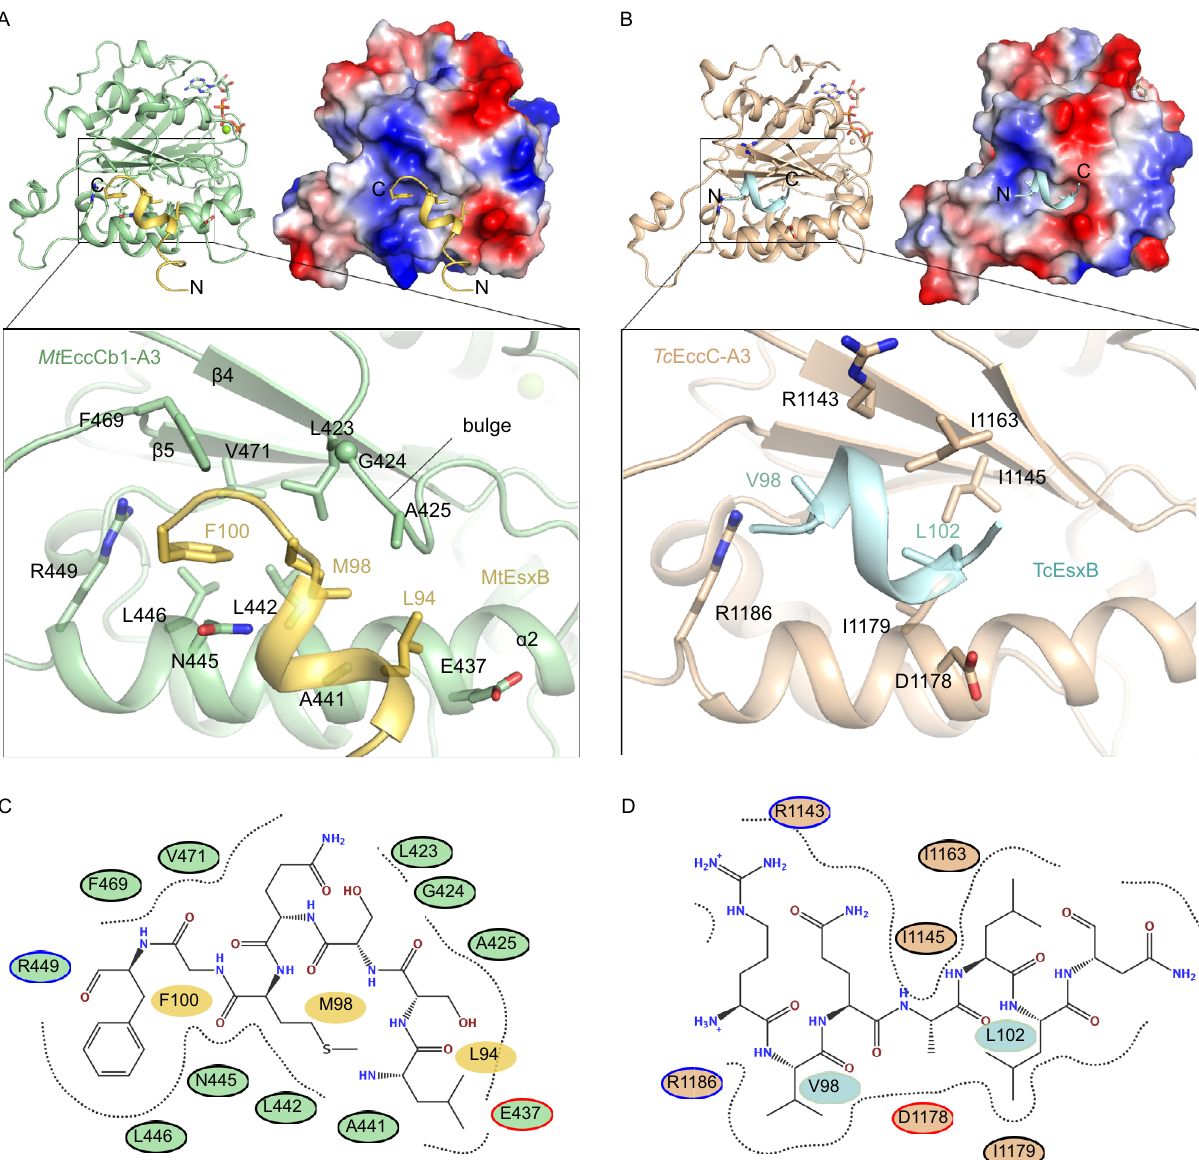
Figure 4. Substrate-speci fi c recognition of EccCb1-ATPase 3 from Mycobacterium tuberculosis and EccC-ATPase 3 from Thermomonospora curvata . (A) (Upper left) A cartoon image of Mt EccCb1-ATPase 3 (pale green) in complex with Mt EsxB (yellow). (Upper right) The same complex but shown as an electrostatic surface. (Bottom image) A zoom-in view of the interactions at binding pocket. N/C, the N-/C-terminal end of peptide. (B) (Upper left) A cartoon image of Tc EccC1-ATPase 3 (wheat) in complex with the C-terminal region of Tc EsxB (pale cyan) (PDB code: 4N1A). (Upper right) The same complex but Tc EccC1-ATPase 3 is shown as an electrostatic surface. (Bottom image) A zoom-in view of the interactions at binding pocket. (C) Schematic diagram of the interactions between Mt EccCb1-ATPase 3 and Mt EsxB at the recognition pocket. (D) Schematic diagram of the interactions between Tc EccC1- ATPase 3 and Tc EsxB at the recognition